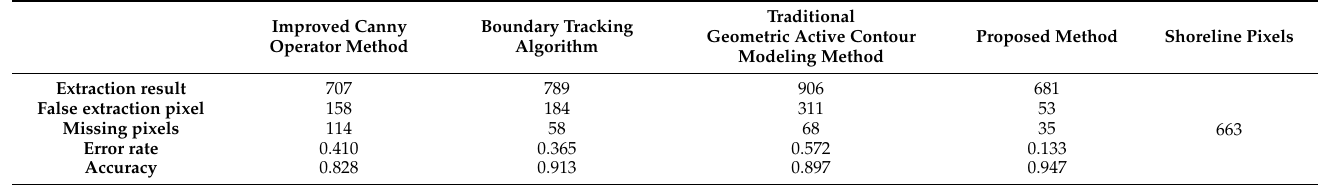
Table 1. Algorithm extraction performance